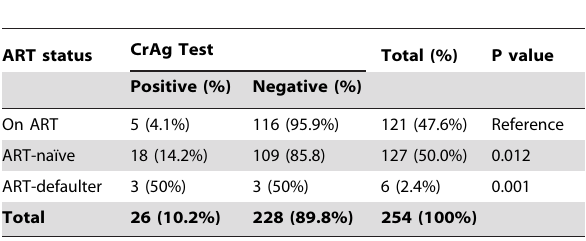
Table 2. Cryptococcal antigenemia and Antiretroviral Therapy (ART) status.